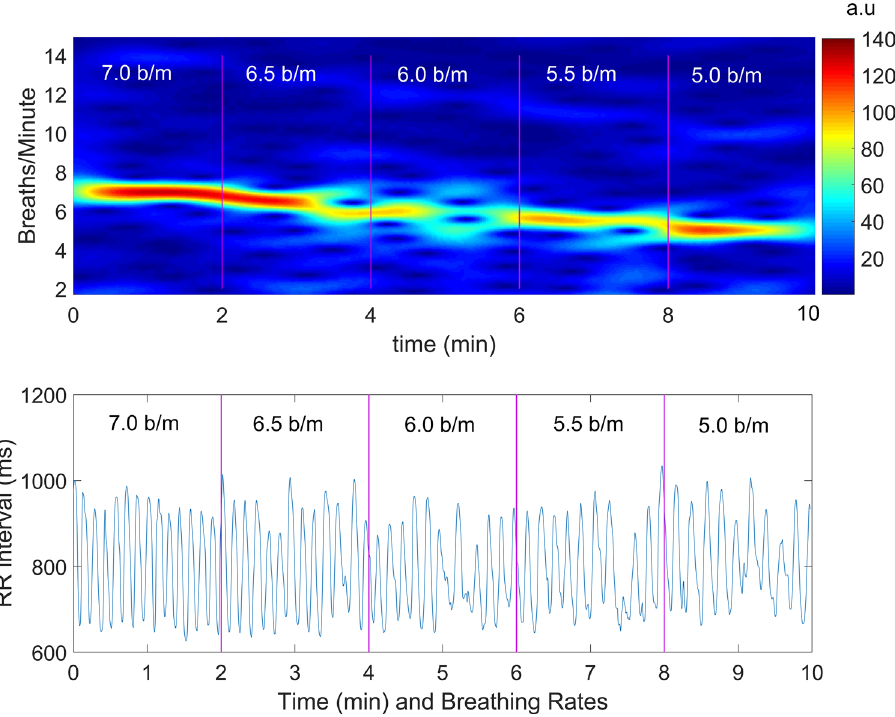
Figure 3. Representation of the spectrogram analysis (STFT, 120 s window, 1.5 s resolution, Hann window) of the IBI series (bottom trace) for each breathing rate (7, 6.5, 6, 5.5, 5 b/m) during the HRVB of Participant 15 during the Test session. Hotter color means more respiration energy of the signal and colder less, represented in arbitrary units. During this session, P15 breathed following the metronome with a clear pattern, hotter in 7 b/m (RF). (RR interval: IBI).